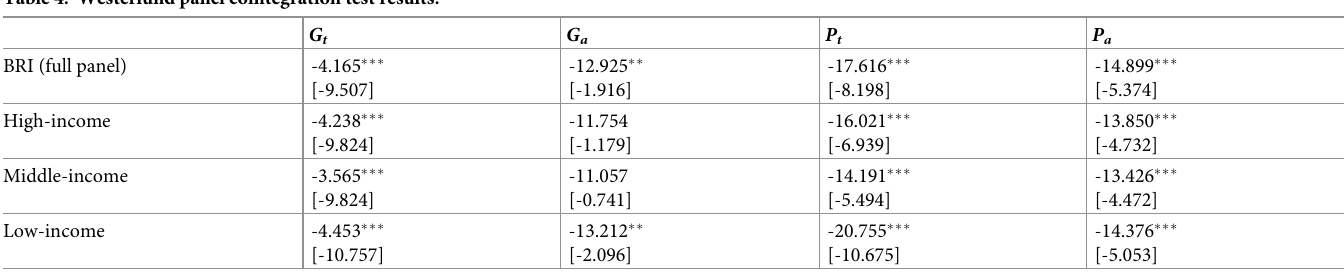
Table 4. Westerlund panel cointegration test results.